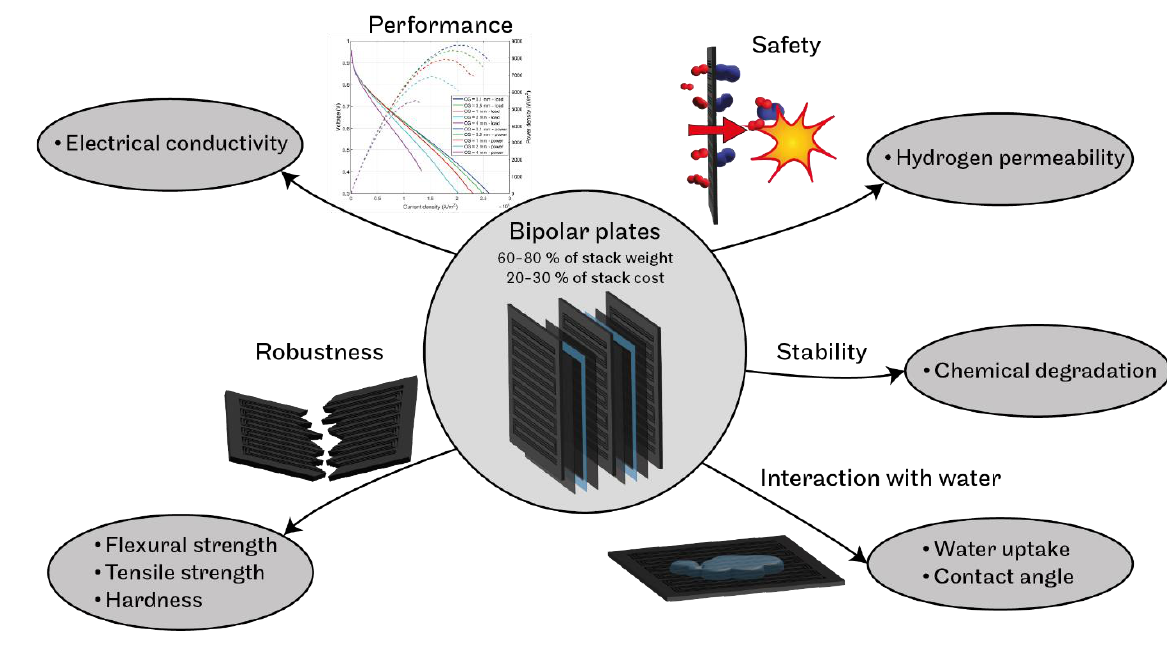
Figure 1. Studied BP parameters and the related aspects.